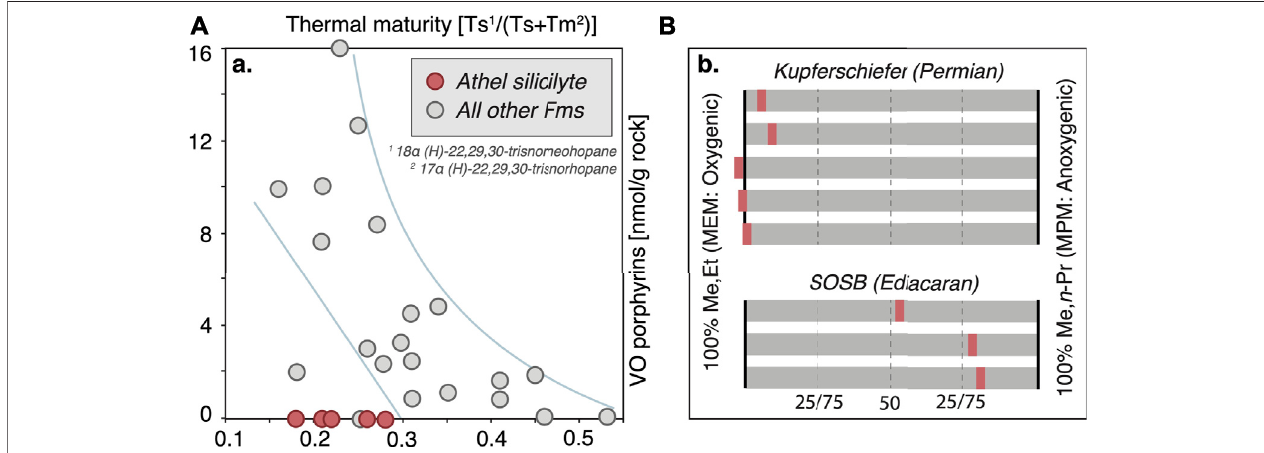
FIGURE 6 | Preservation of porphyrins and mass balance of autotrophy. (A) Porphyrin abundances are a function of preservation and thermal maturity (based on the hopanoids Ts and Tm; see main text). VO-porphyrins are systematically absent from the Athel Fm (red symbols) despite a suitable thermal maturity, pointing to strongly differing ecologies or environmental conditions. (B) Isotopic mass balance calculations ( 13 C for the Kupferschiefer after Grice et al., 1997: Supplementary Table S3 ; 15 N for the SOSB: Table 2 ) on the basis of comparing the isotope value of summed MMM and EEM to those of MEM and MPM end members can hint towardstherelativeproportionofoxygenicvsanoxygenicphototrophicbiomass.SOSBprimaryproductivityduringdepositionoftheU-shale( n (cid:2) 3)wasshiftedtowards amarkedlyhigher contribution ofanoxygenicphototrophs.NegativevaluesforsomeKupferschiefersamples,i.e. δ 13 C MMM+EEM beyondthe0 – 100%spectrumspanned by δ 13 C MEM and δ 13 C MPM , likely derive from analytical error.